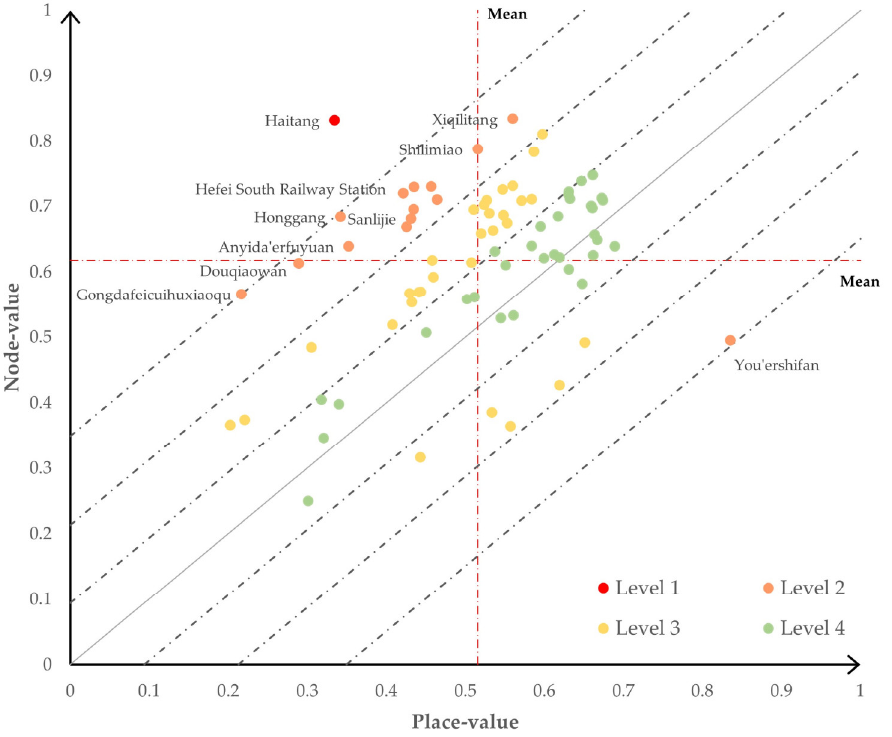
Figure 7. Four priority levels of 77 TODs.